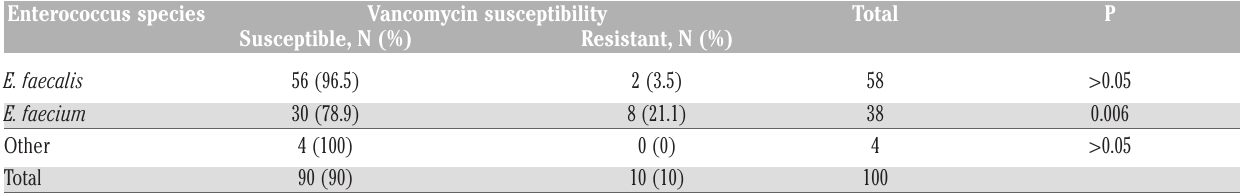
Table 3. Vancomycin susceptibility of Enterococcus species determined by the automated system.